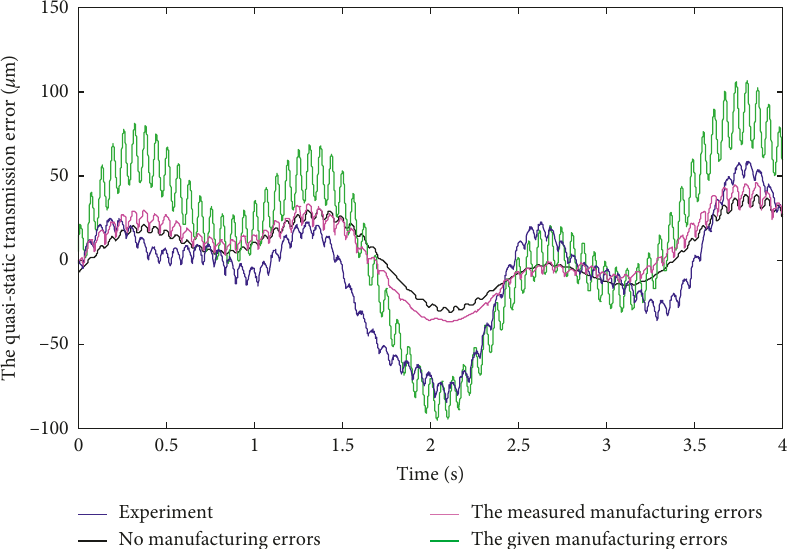
Figure 18: Quasistatic transmission error.